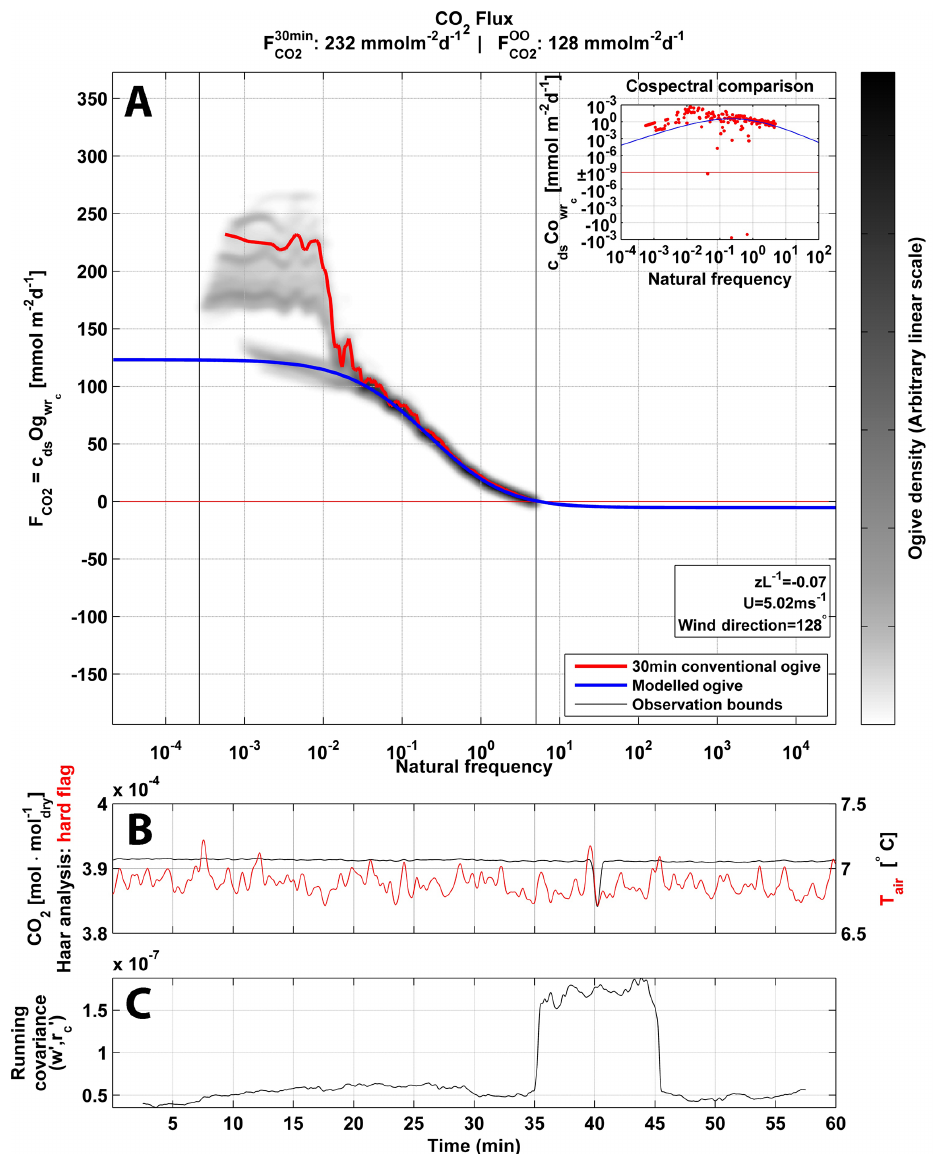
Figure 9. 60min observation of CO 2 flux recorded at Abisko on 10 July 2012 at 3:20a.m. LT. The illustration is similar to Fig. 5, except for the addition of a smoothed raw signals of atmospheric CO 2 (black line) seen in (b)